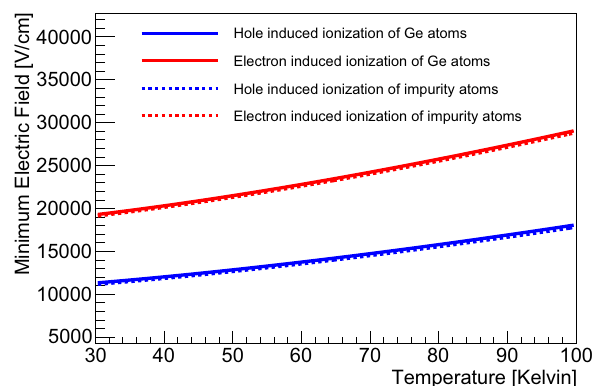
Fig. 4 The minimum electric field required for internal charge ampli- fication of Ge atoms and impurity atoms in a temperature range from 30 to 100 K